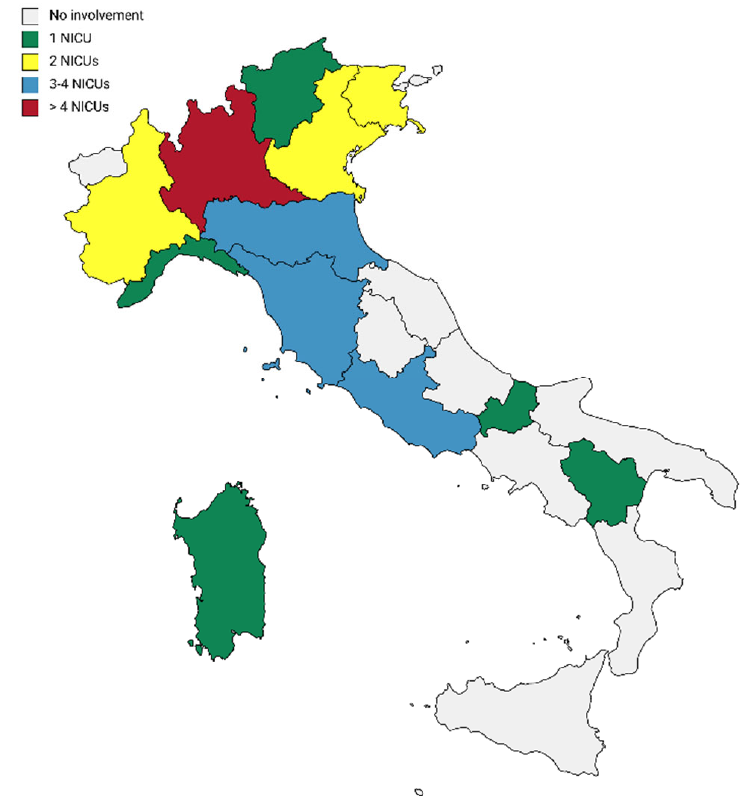
Figure 1. Distribution of the NICUs participating in the study. Table 1. Sociodemographic Characteristics of the Sample (n = 921)